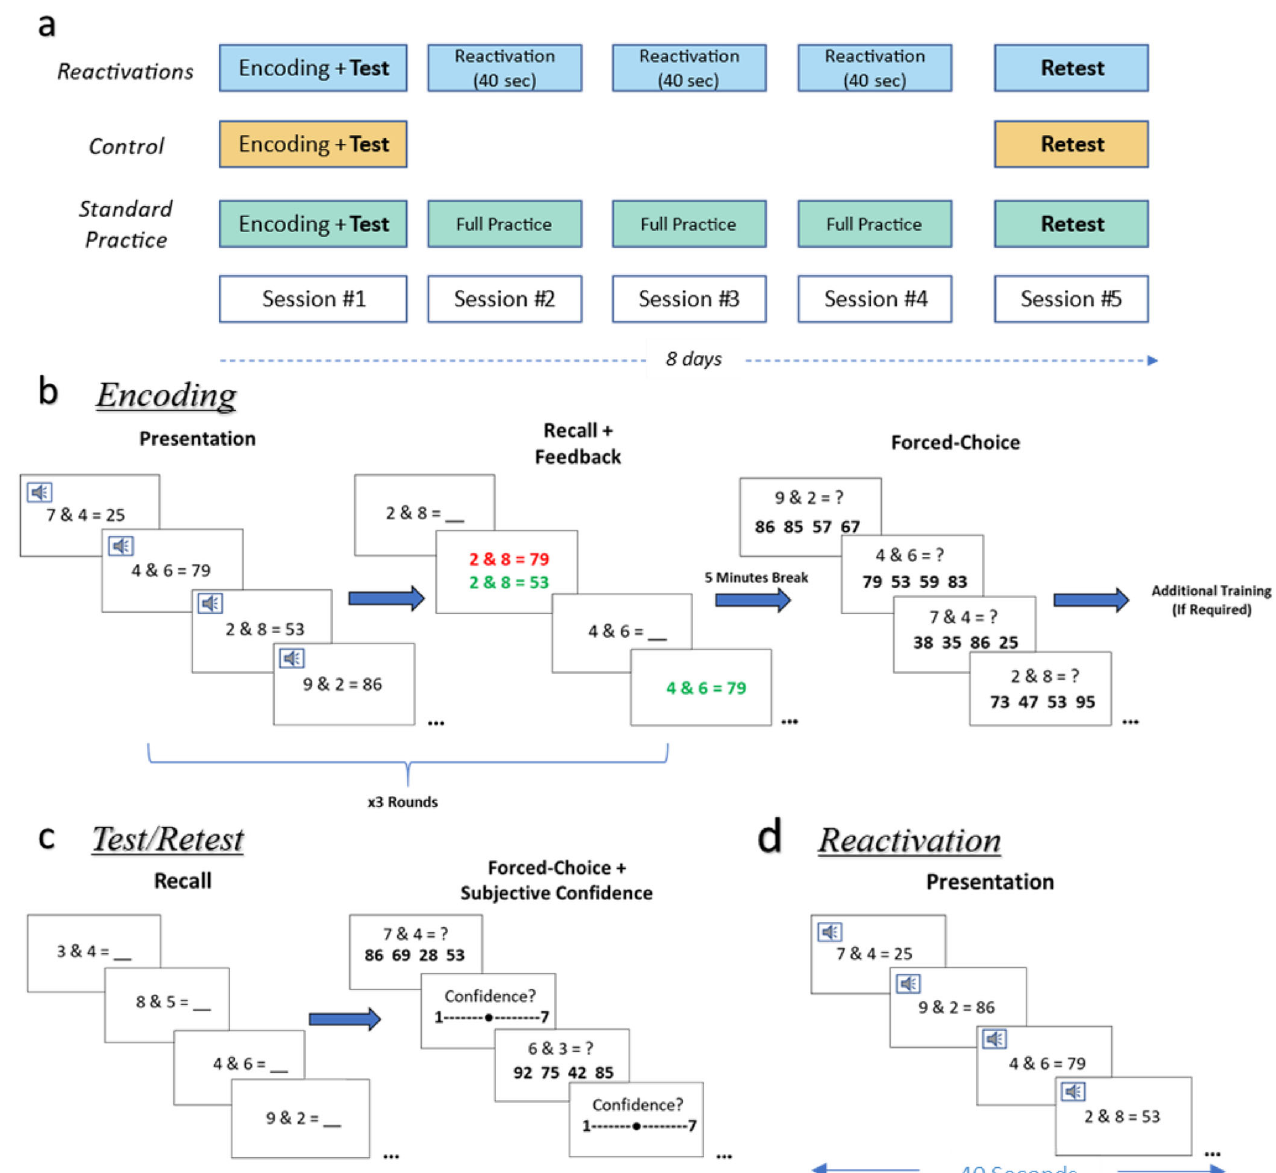
Fig. 1 Number-fact retrieval task. (a) Experimental design. Participants fi rst encoded the facts and were tested for baseline performance following 30 minutes. Participants in the Reactivations group performed 3 brief reactivation sessions in which their memory was brie fl y reactivated for only 40 seconds of passive facts presentation. The Control group performed the test and retest sessions without reactivations. Participants in the Standard Practice group performed 3 full practice sessions between test and retest, each containing 3 rounds of facts presentation and recall with feedback. Retest sessions were conducted 8 days following the 1 st session. (b) Encoding Session: included 3 rounds of active-retrieval practice. Each round consisted of a presentation stage and a recall stage with feedback (correct response = green, wrong response = red accompanied with the correct answer). Participants were asked to fi ll-in the result as accurately and as fast as they can within a time limit of 8 seconds. Following a 5-minute break, they solved each fact as a 4-alternative forced-choice question in order to determine if an additional training round is required for ef fi cient encoding. Accordingly, an additional practice round was performed for facts with incorrect forced-choice answers. (c) Test/Retest Session: consisted of a free recall round, followed by a forced-choice questions round. After each forced-choice question, participants rated their subjective con fi dence in their answer. (d) Reactivation Session: consisted of fi ve seconds of a visual-auditory presentation of each fact in random order, for a total of 40